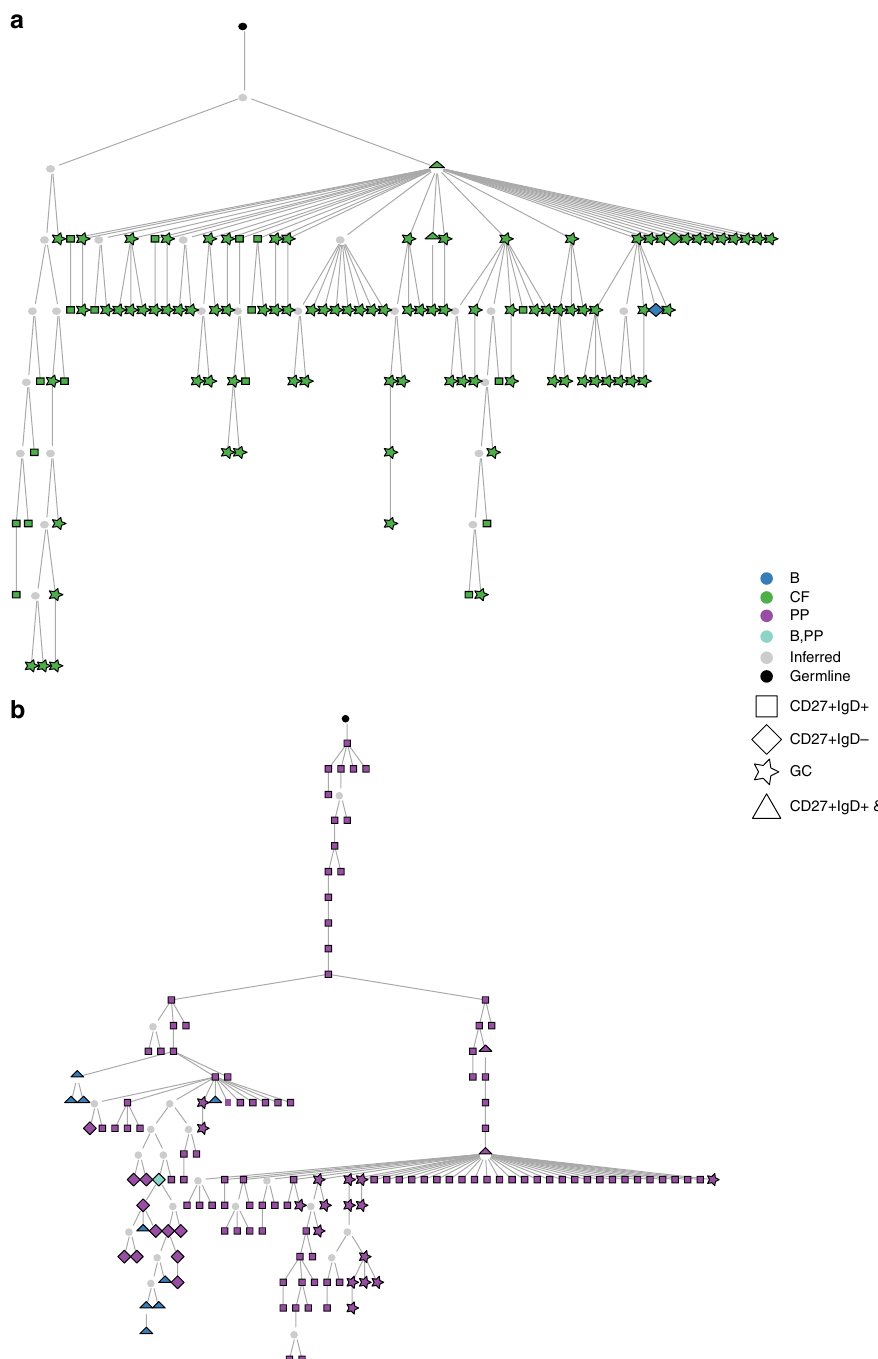
Fig. 7 CD27 + IgM + IgD + cells diversify their receptors in gut GC. a , b Lineage trees including clone members isolated from GC of GALT, CD27 + IgM + IgD + cells from GALT and in ( b ) also CD27 + IgM + IgD + cells from blood. CD27 + IgM + IgD + cells before and after the GC phase were identi fi ed, indicating that the response is current and dynamic and generating cells enter and exit the GC response with the same (CD27 + IgM + IgD + ) phenotype. CD27 + IgM + IgD − clone members can also be identi fi ed. Recombining segments and junctional sequences of the MRCA of the clones are: a , IGHV3-33,